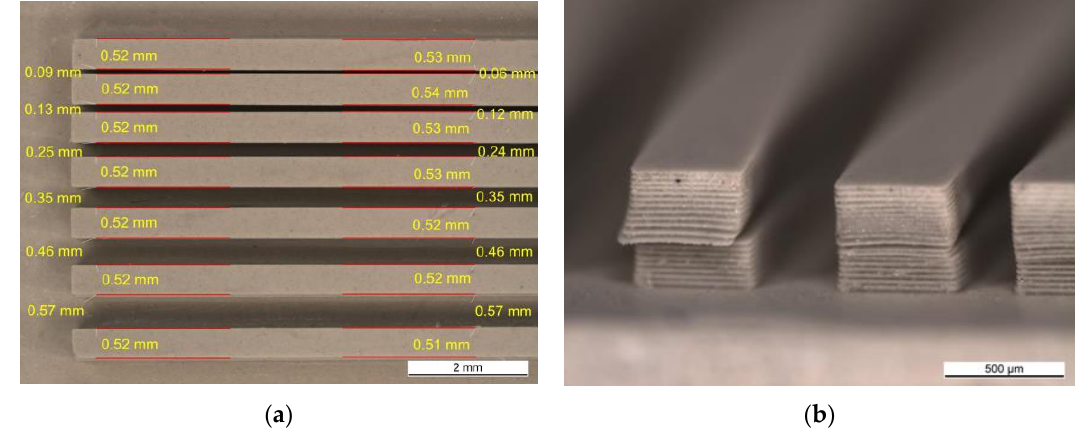
Figure 7. Plate with channels structure fabricated on the LCM device from a suspension containing 0.5 wt % TPO-L. ( a ) top view, ( b ) side view.